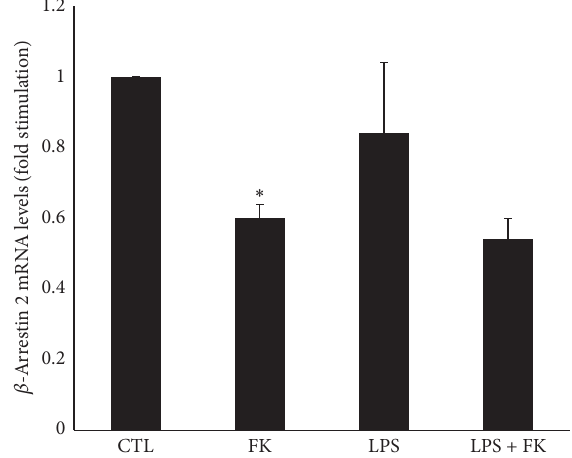
Figure 5: mRNA expression of 𝛽 -Arrestin 2 in differentiated 3T3-L1 cells treated with LPS in the presence or absence of FK. Differentiated3T3-L1cellsweretreatedasdescribedinMaterialsand Methods under the following conditions: CTL, 10 𝜇 M FK, 1 𝜇 g/mL LPS, and LPS + FK. The results are expressed as mRNA levels (fold stimulation over CTL set to 1) and are the means ± SEM of 3 independent experiments. Data were analyzed using 𝑡 -test for unique sample and paired 𝑡 -test; ∗ 𝑝 < 0.05 versus